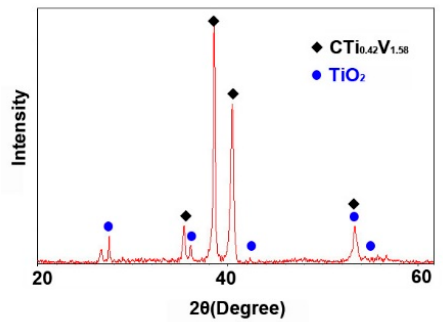
Figure 10. The XRD phase analysis of the Ti-6Al-4V bonding surface at speed of 10